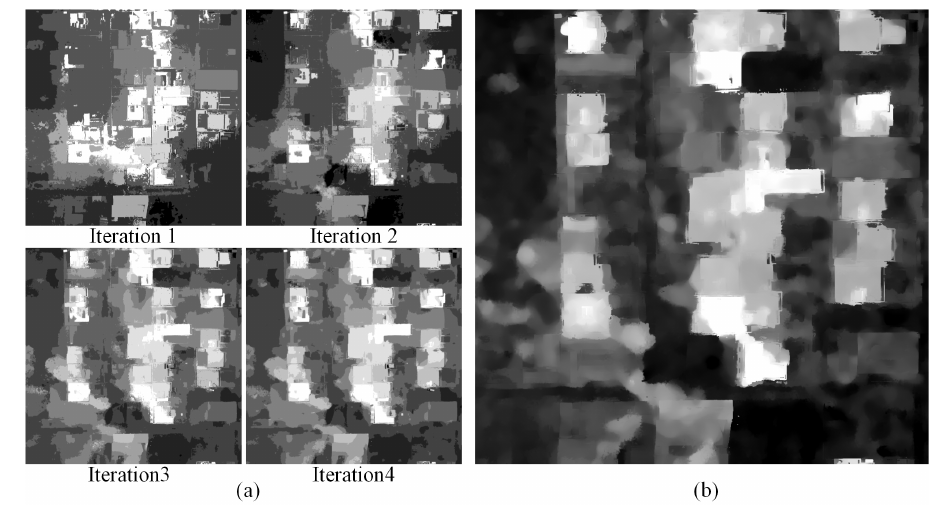
Figure 5. Results of disparity estimation in the (a) pixel-level steps and (b) subpixel refinement step of the proposed